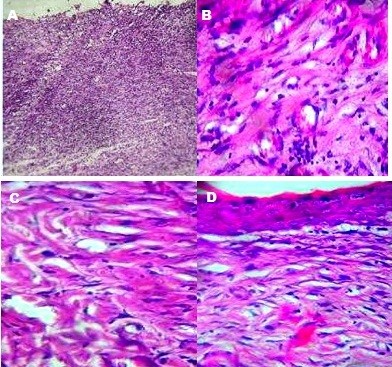
Histopatholigically, Kumbucha treatment group in different days. A Fourth day, Loss off epithelial associated with angiogenesis and inflammation, B: Eighth and twelfth day , loss of epithelial associated with abundant vessels and excessive inflammation and newly formed blood vessels and scarce amount of inflammatory elements, C: Sixteenth day, relatively good after healing after sixteenth day and dermal appendages destroyed, D: Twentieth day, Healing is crazy acceptable.